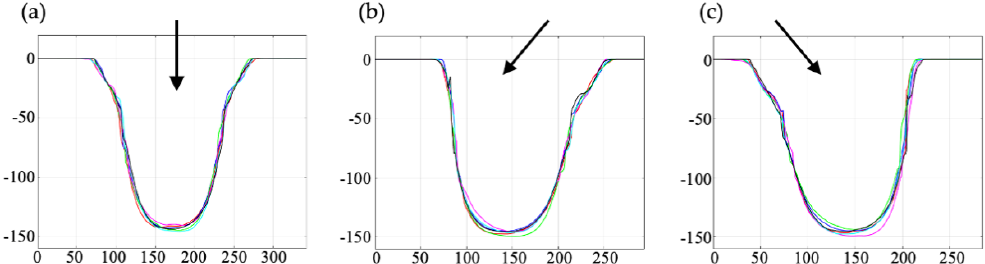
Figure 4. Cut-section profiles of the outlet channels that are placed 0 ◦ and ± 40 ◦ relatively to the laser axis. ( a ) Aligning the structures with the laser axis results in symmetric walls. ( b , c ) Structures placed not aligned with the laser axis ( ± 40 ◦ ) will be asymmetric where the wall facing the laser will have a steeper slope than the wall facing away from the laser axis. The arrow indicates the direction of the laser. Six structures for each position were evaluated, and all values are in µm.